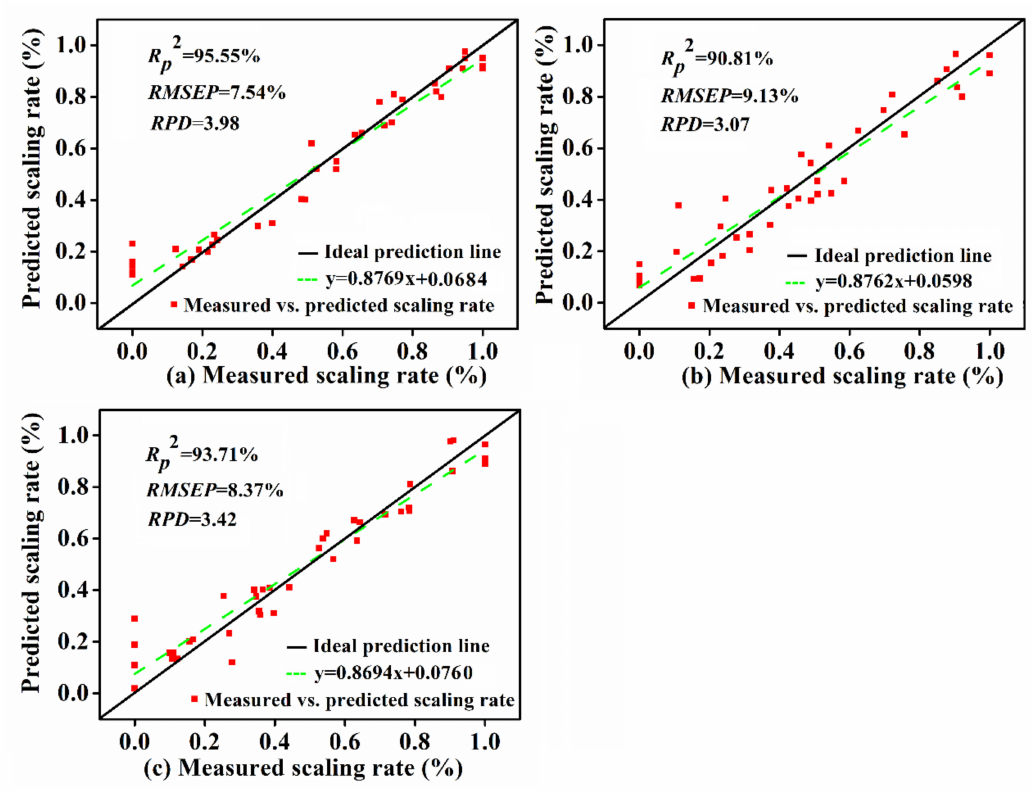
Figure 7. Measured scaling rate vs. predicted scaling rate by the optimal model in ( a ) back, ( b ) belly, and ( c ) tail regions of carp in the prediction